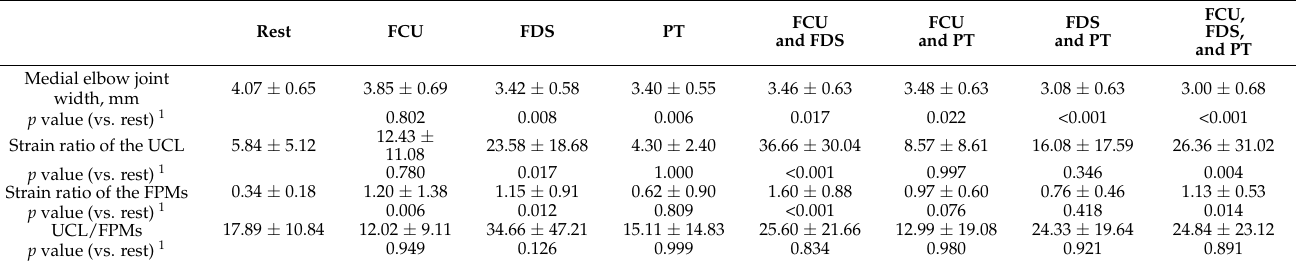
Table 1. Changes in medial elbow joint parameters due to selective contractions of the FPMs (n = 20). Rest FCU FDS PT FCU and